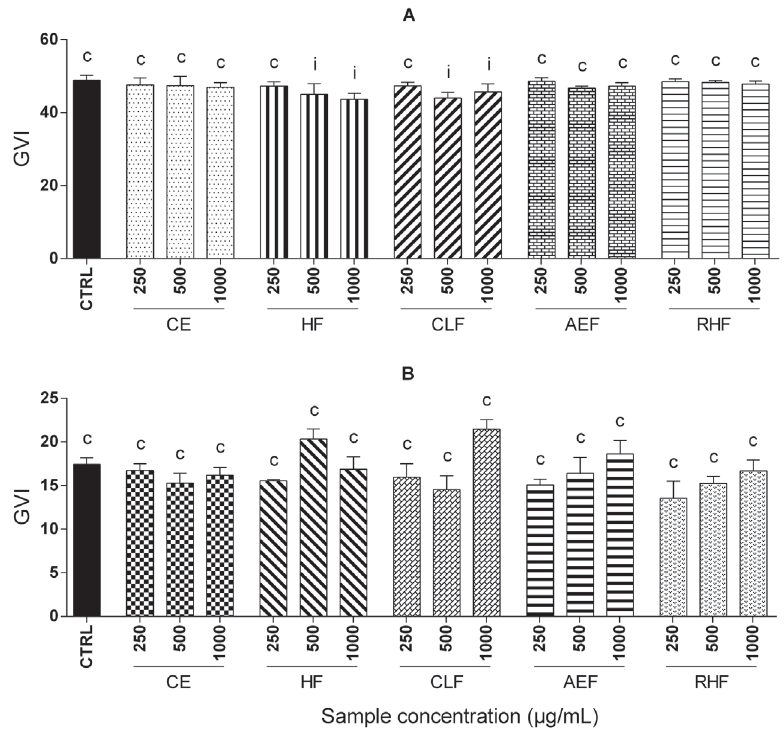
FIGURE 1 - Germination velocity index (GVI) of L. sativa (A) and A. cepa (B). Treatment means differ significantly (p< 0.05) when compared to control means i inhibiting or e stimulating germination velocity by Scott-Knott test. Treatment means do not differ significantly from c control